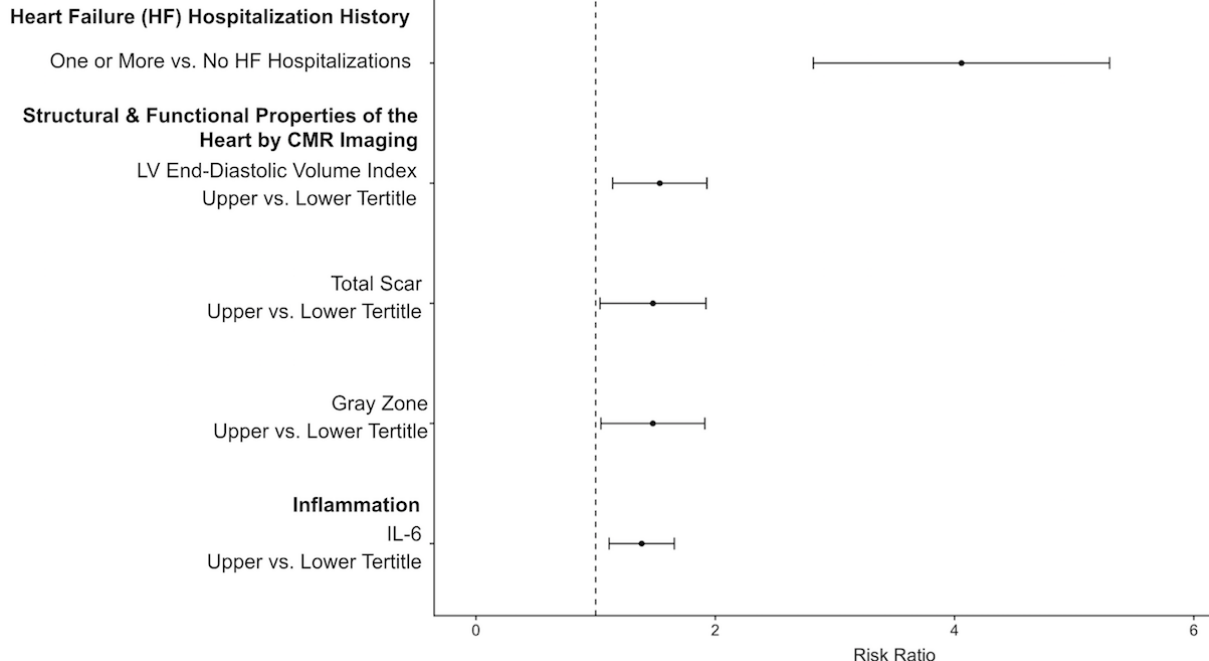
Figure 4. Visualization of predictor effects in random forest (RF) model for sudden cardiac death (SCD) prediction: Risk ratio point estimates and the 95% confidence intervals generated from 500 bootstrap replications are shown for the RF model for SCD risk prediction. The largest risk ratio is between individuals who never experienced a heart failure hospitalization and those who experienced one or more heart failure hospitalizations. The other risk ratio comparisons show the risk ratios between individuals grouped into different categories based upon inflammation or cardiac magnetic resonance (CMR) imaging variables indicating the structural and functional properties of the heart. HF: heart failure; IL-6: interleukin 6; LV: left ventricular.